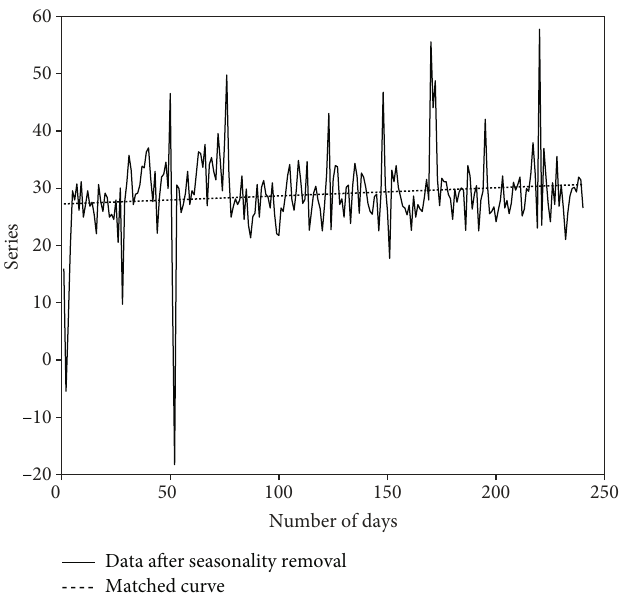
Figure 1: Time fi tted series (take the example of data centralization provider 007).